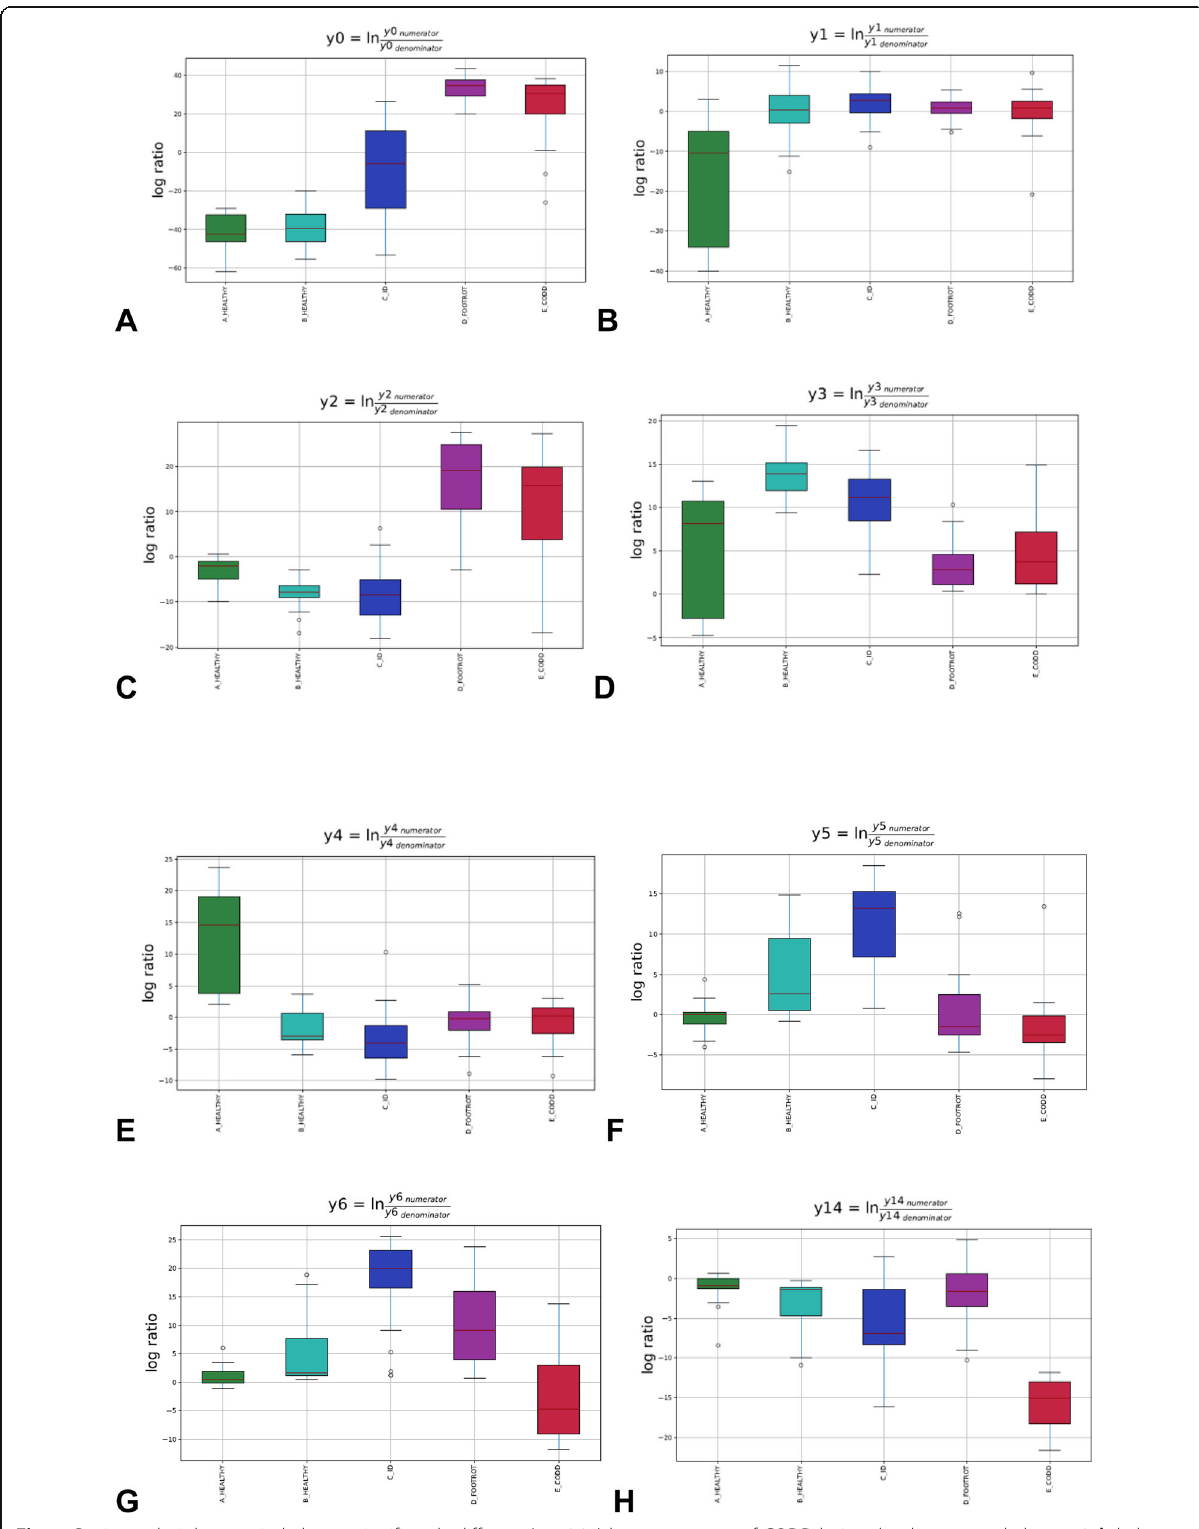
Fig. 5 Gneiss analysis log 10 ratio balances significantly different ( p < 0.05) between stages of CODD lesion development. a balance y0, b balance y1, c balance y2, d balance y3, e balance y4( a ), f balance y5, g balance y6, h balance y14. A lower log 10 ratio shows a shift in the balance toward denominator ASVs whilst a higher log 10 ratio shows a shift towards numerator ASVs as visually represented in Fig.